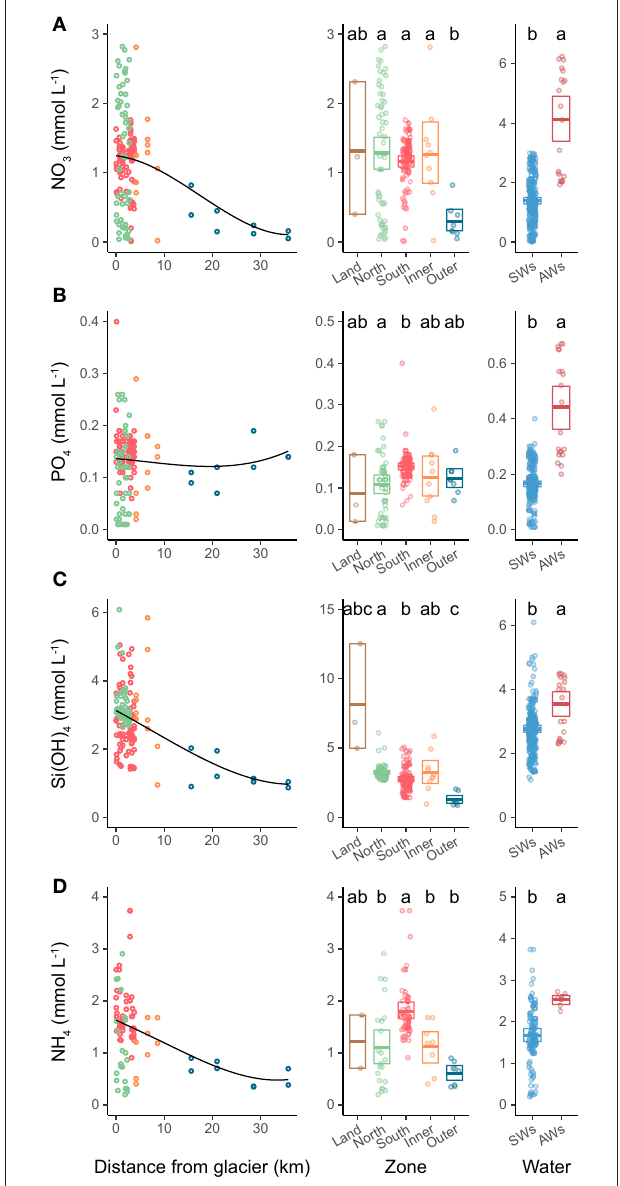
FIGURE 7 | Nutrient concentrations in relation to distance from glacier (left panels), comparison among zones (mid panels) and among water types (right panels). Left and mid panels represent nutrients sampled between 0 and 10m. The black line in left panels indicates local polynomial regression fit. The panels on the right include all depths from Southern and Northern Glacier Zones, with water masses as in Figure 3 . (A) nitrate, (B) phosphate, (C) silicic acid, and (D) ammonium. Letters on right panels indicate pairwise permutation test results: differing letters indicate significantly different nutrient concentrations between zones. The crossbars indicate mean values and box margins bootstrapped 95% confidence intervals. Points represent values for individual samples.